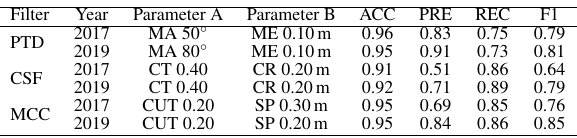
Figure 8 highlights the points classified as non-ground on the debris cone using each technique, applying the best parameter sets identified in the vegetated test area. Despite the